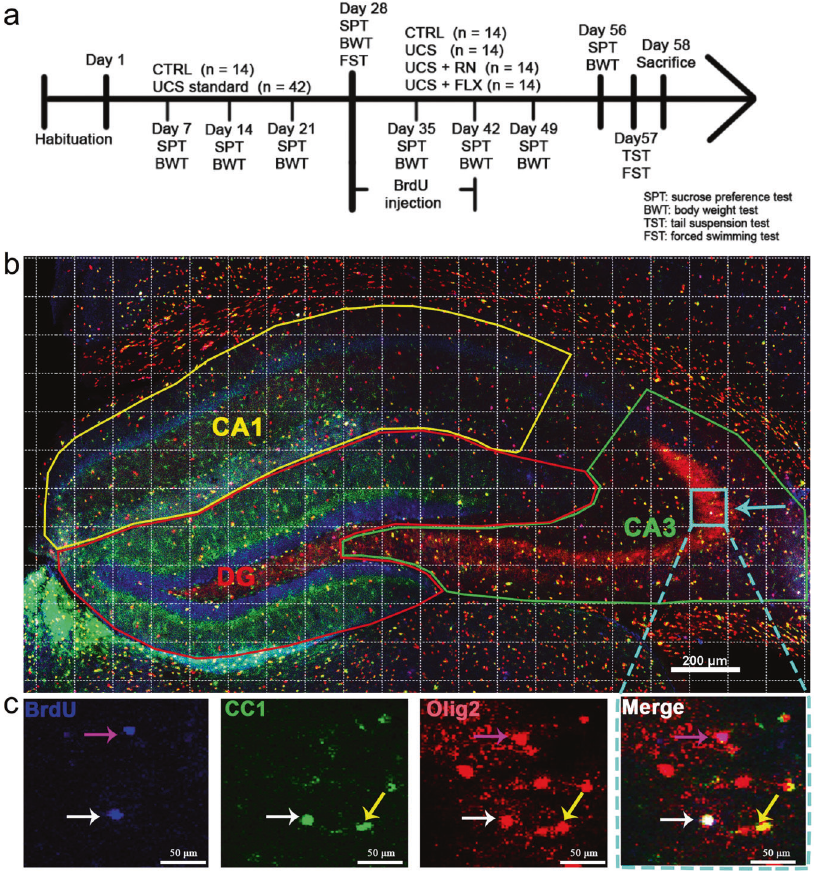
Fig. 1 Behavior experiment timeline and illustration of immuno fl uorescence staining on the whole hippocampus. a Behavior experiment timeline. The experiment lasted for 65 days. b Immuno fl uorescence staining for CC1 (green), Olig2 (red), and BrdU (blue) throughout the hippocampus. For quantitative evaluation of co-labeled cells, a rectangular grid was superimposed on the hippocampus, and 12 – 15 fi elds (100 × 100 μ m 2 ) were systematically and randomly sampled from the CA1 (yellow line), CA3 (green line), and DG (red line) sub fi elds of one section. Scale bar = 200 μ m. c Magni fi ed view of the blue grid indicated by the blue arrow in Fig. 1b. The white arrow indicates a CC1 + /Olig2 + / BrdU + co-labeled cell, the pink arrow indicates an Olig2 + /BrdU + co-labeled cell, and the yellow arrow indicates a CC1 + /Olig2 + co-labeled cell. Scale bar = 50 μ